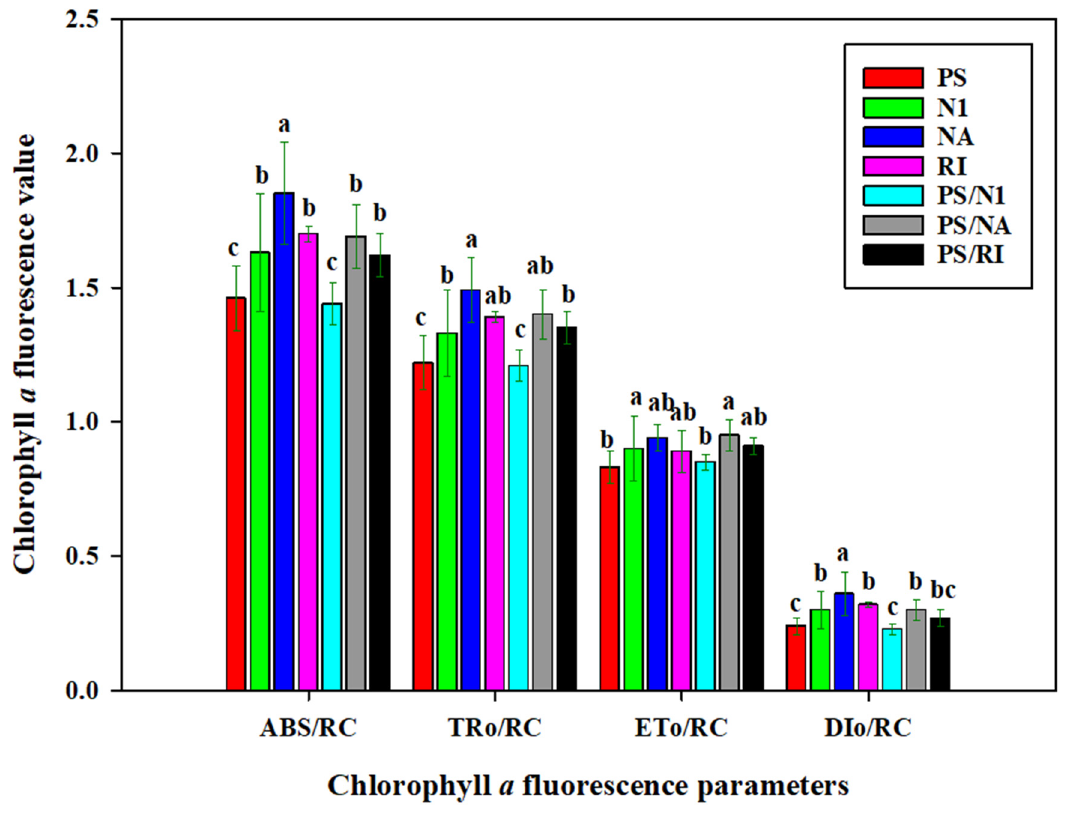
Figure 4. OJIP transient parameters absorbance unit (a.u.) of one scion, three rootstocks, and three grafted cut rose flowers grown in the greenhouse during the summer season. PS: scion plant of spray rose Rosa hybrida cv. Pink Shine; N1: rootstock of Rosa multiflora cv. Hort No. 1; NA: rootstock of Rosa canina cv. Natal Briar; RI: rootstock of Rosa indica cv. Major; PS/N1: PS grafted onto N1; PS/NA: PS grafted onto NA; PS/RI: PS grafted onto RI. Vertical bars are standard deviations ( n = 15). Small letters at the data points indicate mean separation between the values by Duncan’s multiple range test at p = 0.05.